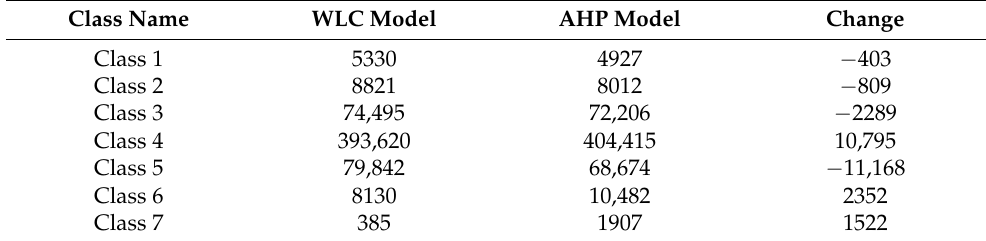
Figure 3. The WLC map ( a ), AHP map ( b ), and the differences in mapped erosion cells between the AHP and WLC map ( c ) are shown. In the difference erosion-potential map, the orange cells are where erosion potential increased with the expert input from the AHP, and green cells are where it decreased. Table 4. Erosion-potential changes between WLC and AHP